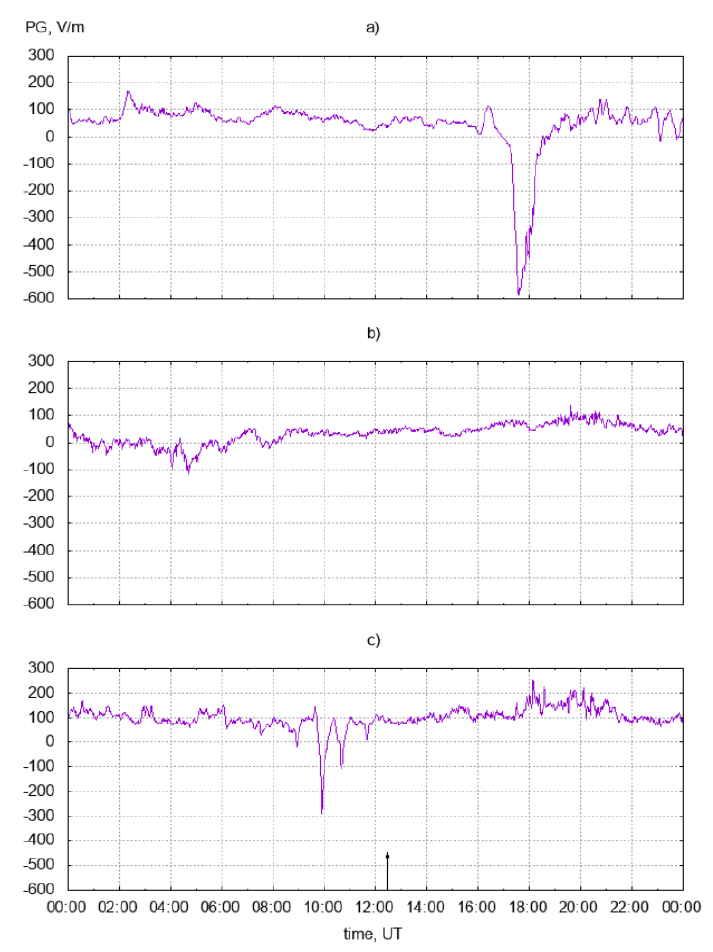
Figure 2. Negative anomalies of the potential gradient on 5 June 1999 ( a ), 8 July 1999 ( b ), and 24 October 1999 ( c ). The arrow indicates the time of an earthquake that occurred on 24 October 1999, K =